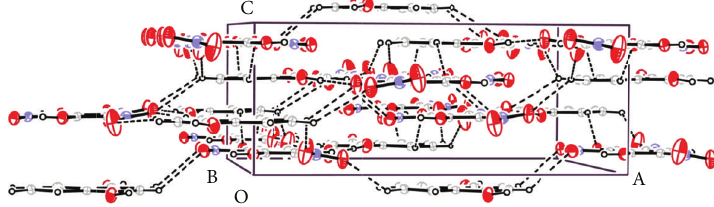
Figure 11: A packing diagram of the molecules; the 𝜋⋅⋅⋅𝜋 interaction was omitted for